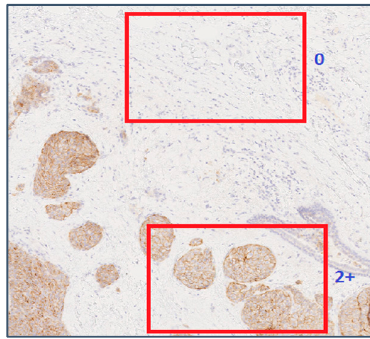
Figure 9. An example showing two tile positions with varying image characteristics within the same WSI. Reproduced from [12] with permission.